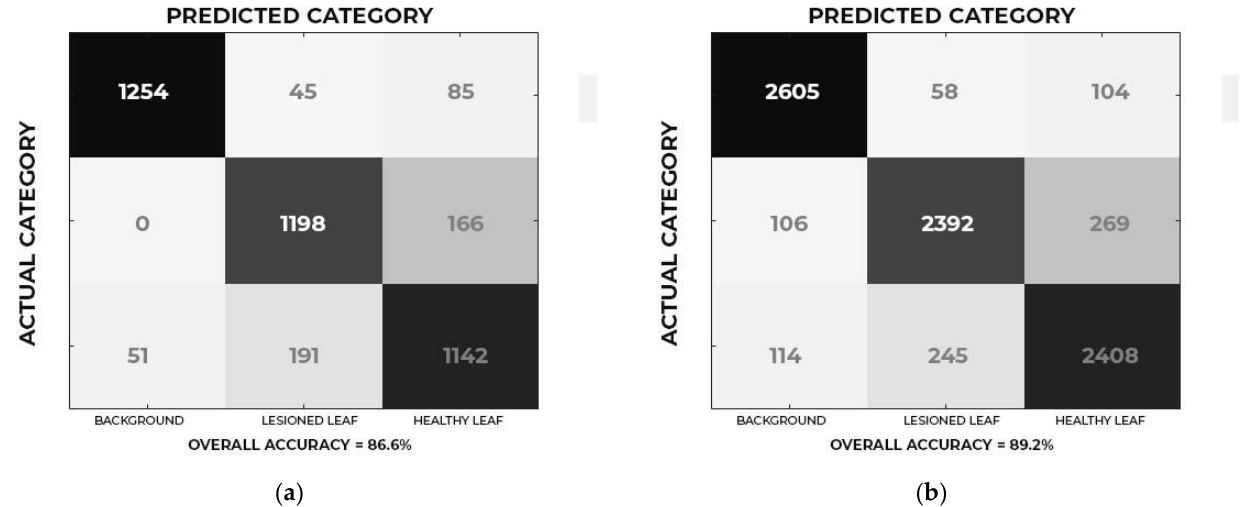
Figure 5. Confusion matrix of the test data for ( a ) Google Net and ( b ) ResNet50.